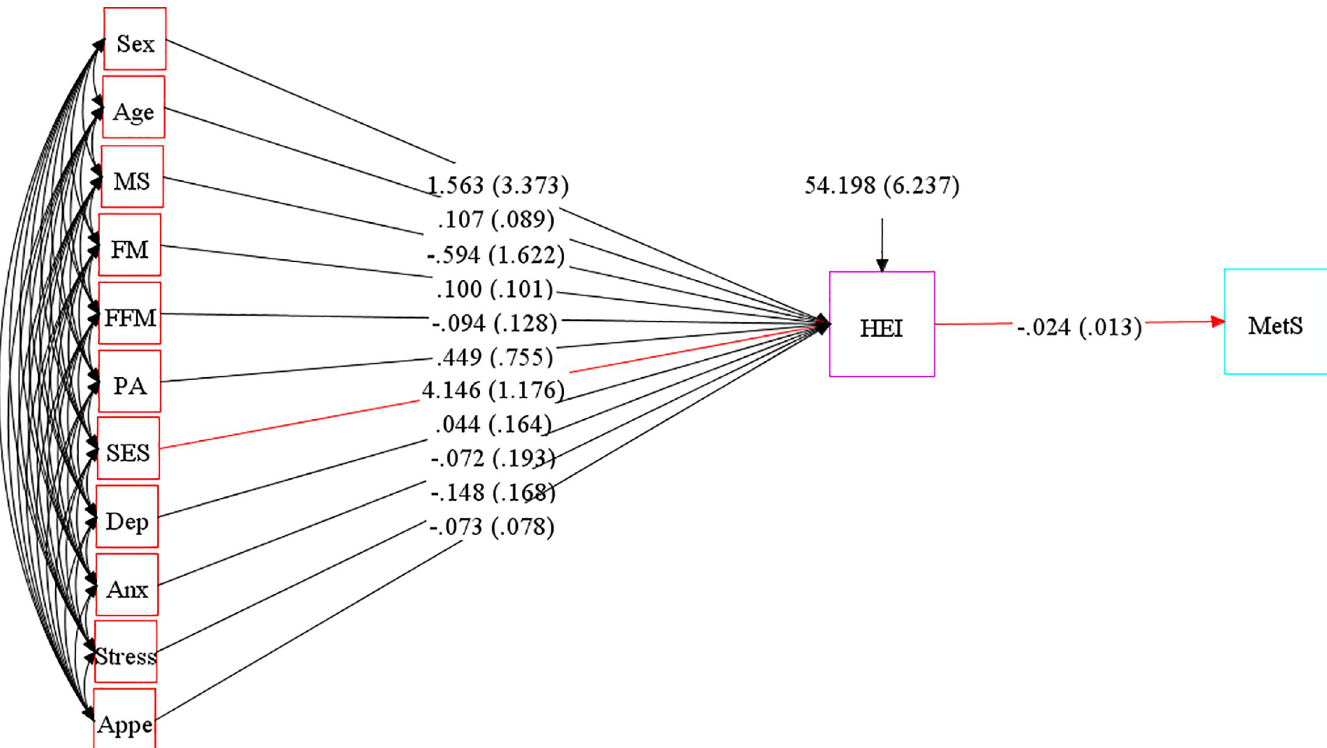
Fig 6. Structural equation model diagram with standardised estimates for total effects of socio-demographic and psychological parameters and diet on Mets. Abbreviations: HEI, healthy eating index;FM, fat mass; FFM, fat free mass; SES, socio-economic status; MetS, metabolic syndrome; PA, Physical activity; MS, marital status; Anx, anxiety; Dep, depression; Appe, appetite. � All path coefficients are standardized. Red arrows mean p.value � 0.05. £ Total effect is defined as the sum of direct and indirect effects. https://doi.org/10.1371/journal.pone.0219193.g006 Table 5. Total effects of socio-demographic and psychological parameters and diet on metabolic syndrome among obese individuals using SEM. Total £ Model